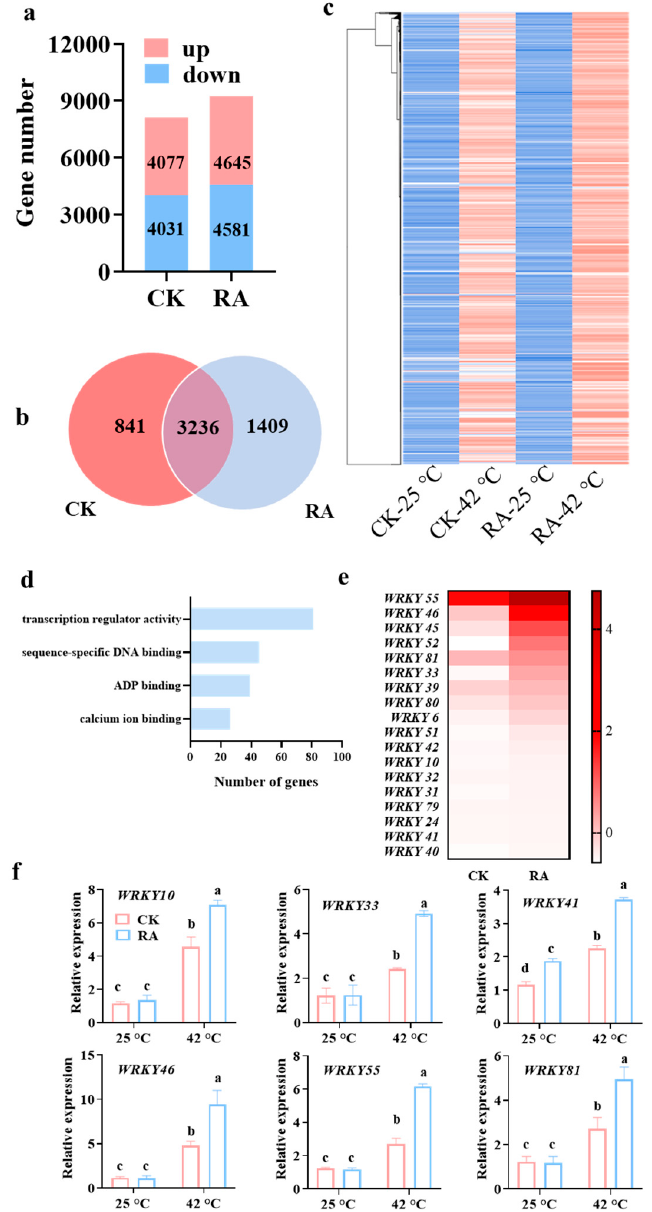
Figure 4. RA globally regulates high temperature-responsive gene expression in tomato plants. ( a ) Numbers of differentially high temperature-changed (fold change ≥ 2, p < 0.05) genes in RA-pretreated or dH 2 O-pretreated tomato plants, respectively. The color gradient scale on the right indicates the relative expression of each gene represented by each color. ( b ) Venn diagram exhibiting the numbers of high temperature-induced genes (fold change ≥ 2, p < 0.05) in RA-pretreated and dH 2 O-pretreated tomato plants. ( c ) Heatmap of high temperature-induced genes (fold change ≥ 2, p < 0.05) in RA-pretreated and dH 2 O-pretreated tomato plants. ( d ) GO analysis of RA-induced high temperature-responsive genes. ( e ) Heatmap of the induction fold of WRKY genes by high temperature in RA-pretreated and dH 2 O-pretreated tomato plants. ( f ) RT-qPCR analysis confirming transcript abundance of selected WRKY genes. The data presented in ( f ) are the mean values ± SD, n = 3. Statistically significant differences between treatments ( p < 0.05, Tukey’s test) are shown by different